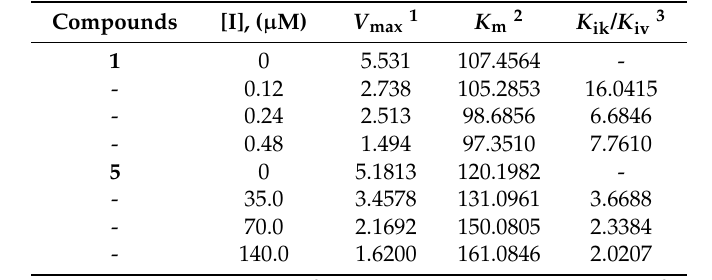
Table 3. Effect of different concentrations of compounds 1 and 5 on V max , K m , and the K ik / K iv ratio using bacterial neuraminidase.